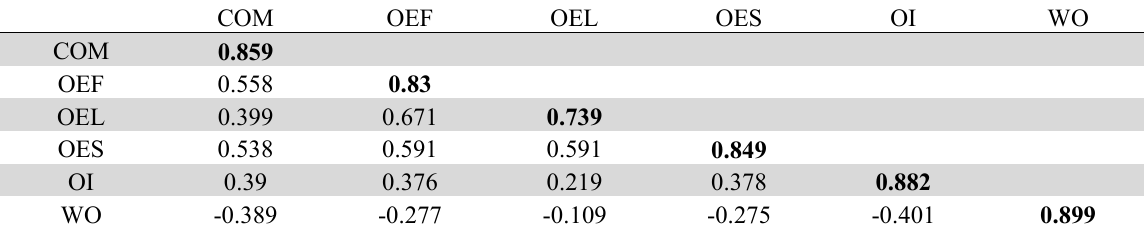
Fornell-Larcker